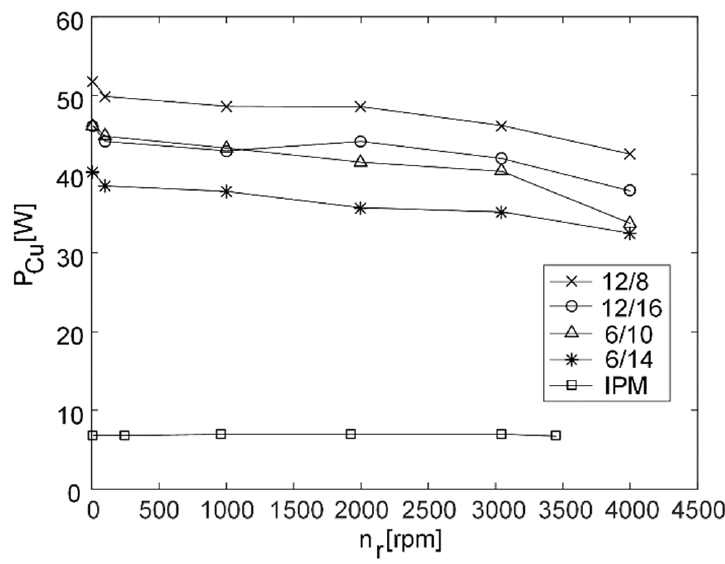
Figure 17. Torque ripple values at different speeds and maximum current.